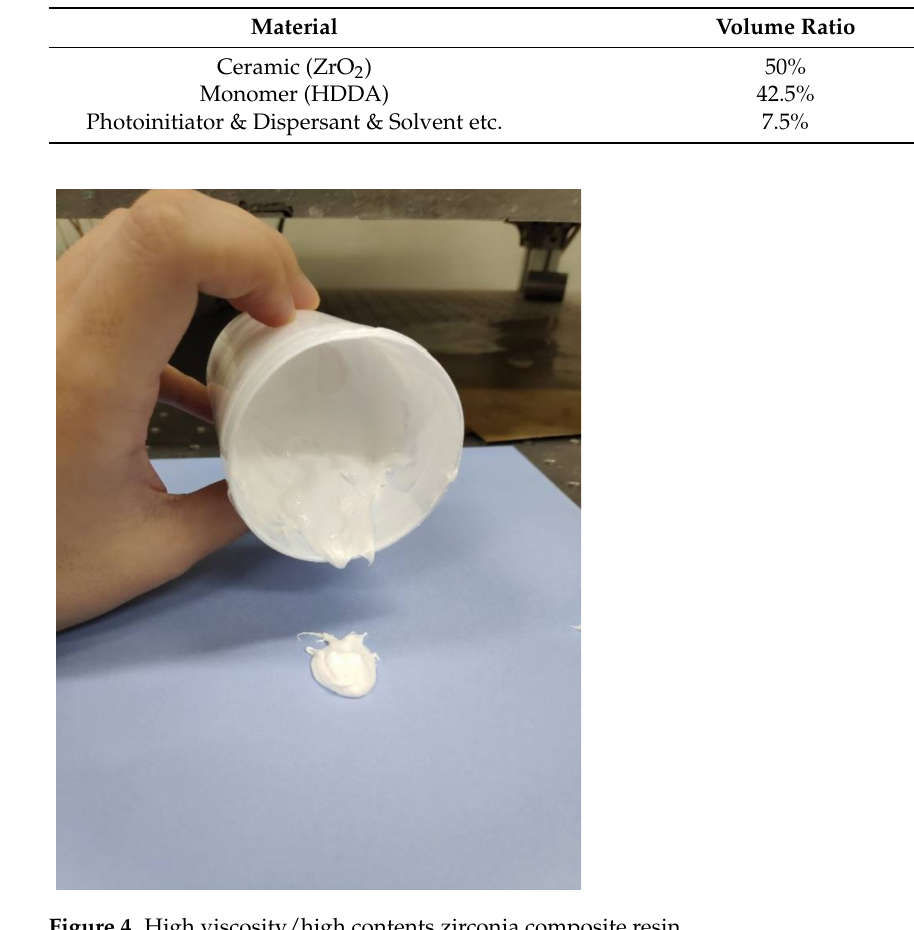
Figure 4. High viscosity/high contents zirconia composite resin.